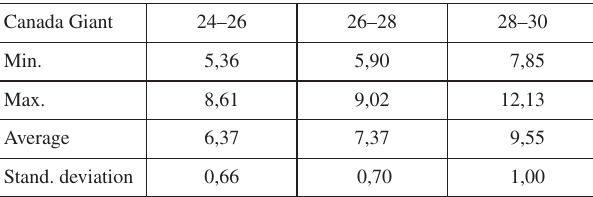
Table 4. The average values for the individual mass (g) Canada Giant